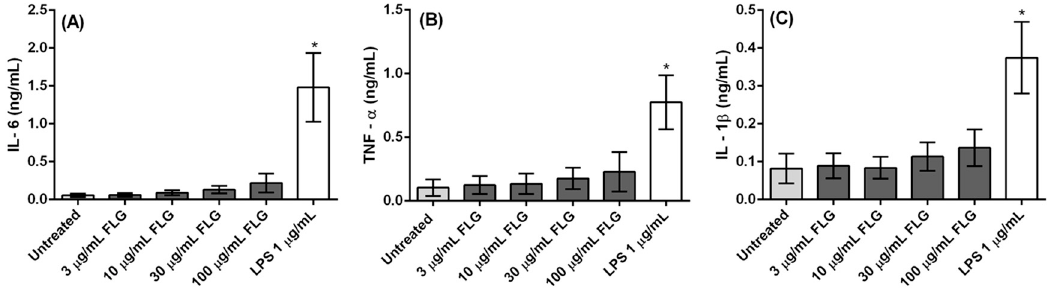
Figure 5. Cytokine secretion by BMDMs. ( A ) IL-6, ( B ) TNF- α , and ( C ) IL-1 β levels in cell supernatant after treatment with or without FLG (3, 10, 30, 100 µg/mL), and LPS (1 µg/mL) for 24 h. A One-way ANOVA followed by Bonferroni’s post-test was performed to determine the statistical differences for control untreated cells versus FLG-treated samples and LPS-treated cells (* p < 0.05).